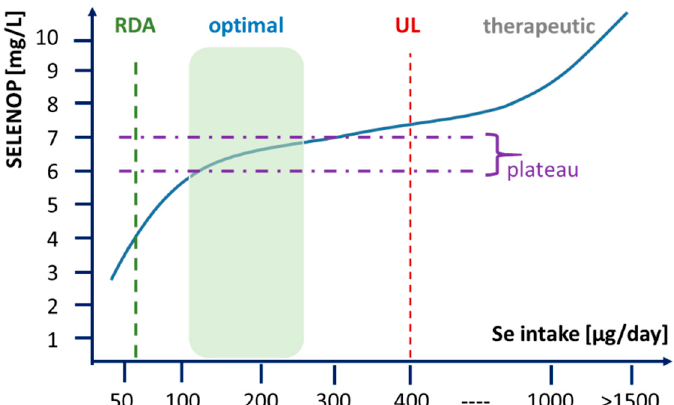
Figure 6. Circulating SELENOP concentrations as biomarkers of Se intake and Se status.